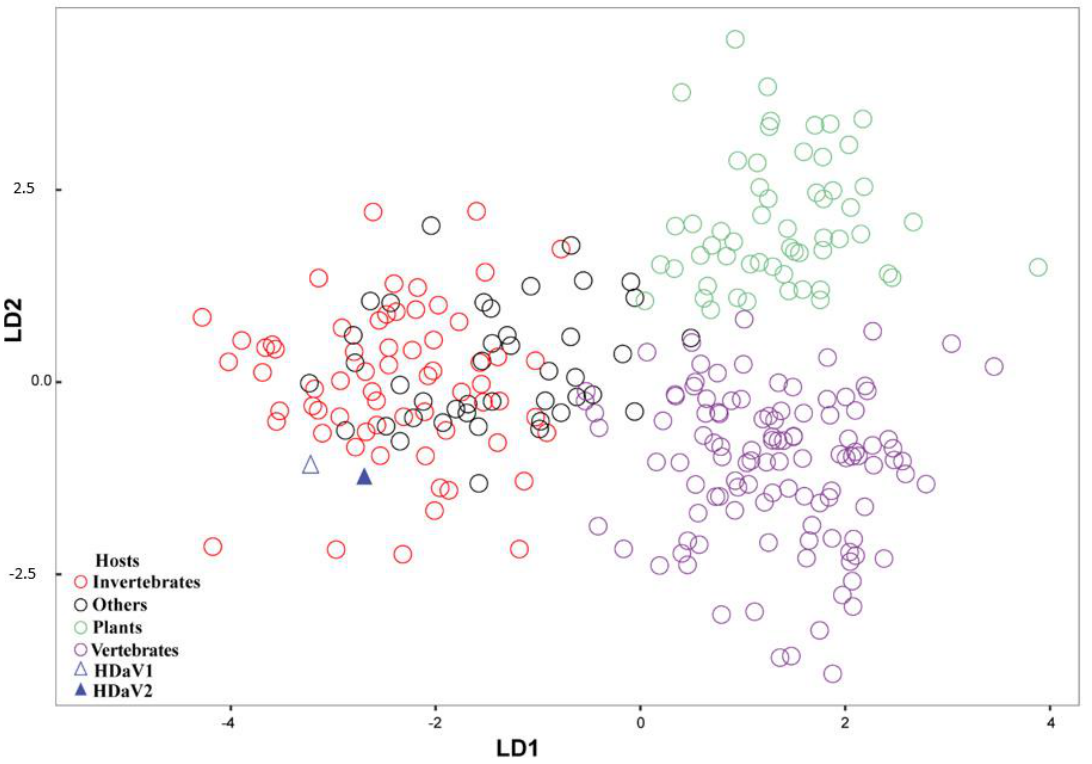
Figure 3. Linear discriminant analysis (LDA) used to classify viral sequences into host groups. Linear discriminant analysis comparing nucleotide composition from members of order Picornavirales with known hosts. Invertebrates - infecting viruses are shown in open red circles, plant - infecting viruses are in open green circles, and vertebrate - infecting viruses in open purple circles; Hovenia dulcis - associated virus 1 (HDaV1) is indicated by an open blue triangle, and Hovenia dulcis - associated virus 2 (HDaV2) is indicated by a solid blue triangle. Other picornaviruses (algae, protozoa, and environmental samples) are shown in open black circles.